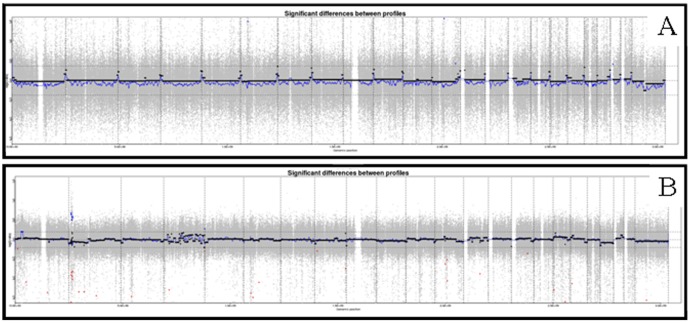
Whole chromosome plots.Array-CGH from SK-N-DZ (A) and SIMA (B) cell lines. The X-axis represents the chromosomes while the Y-axis represent the normalize log2 ratio fluorescence intensity thresholds −1 (loss) and 1 (gain). The results show gains and losses of small chromosomal regions.